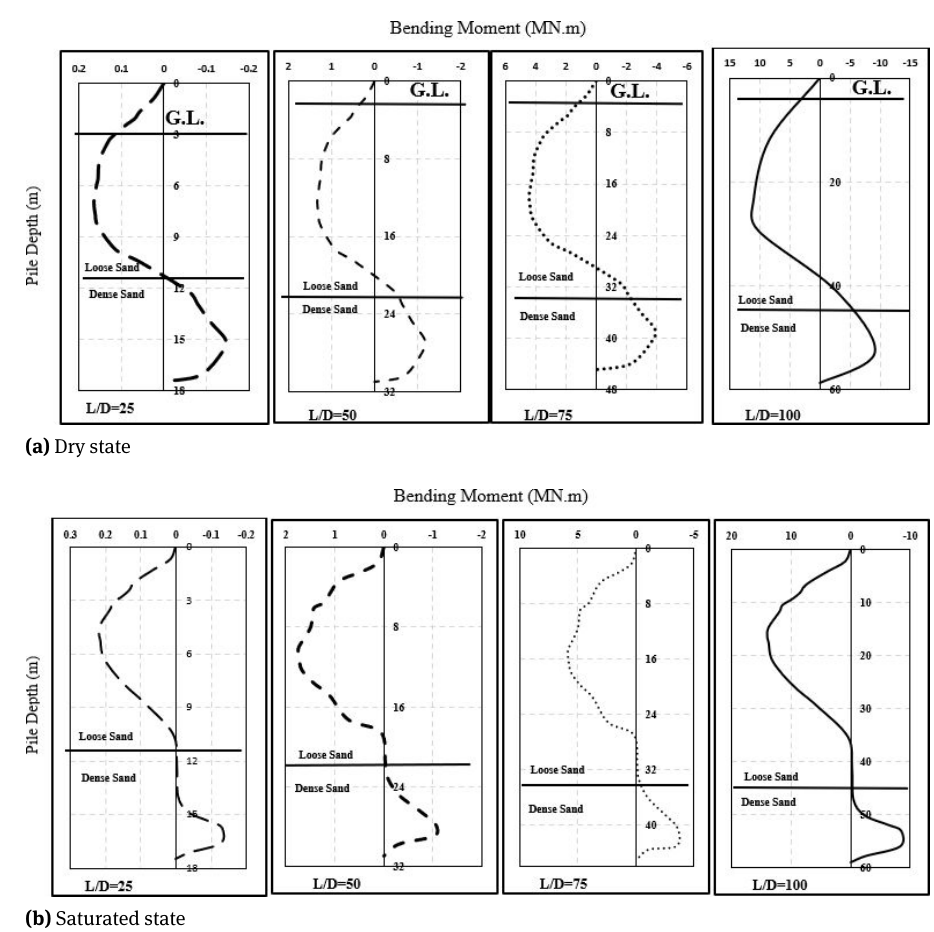
Figure 5: Maximum bending moment along the pile shaft at the PGA on the pile head (around 8.63 seconds)